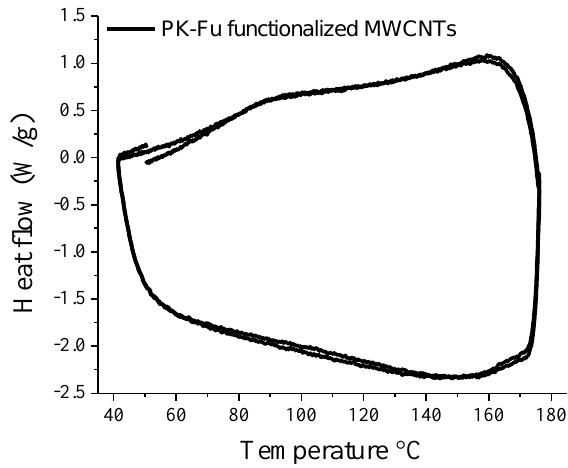
Figure 5. DCS thermal cycles of the PK-Fu functionalised MWCNTs.